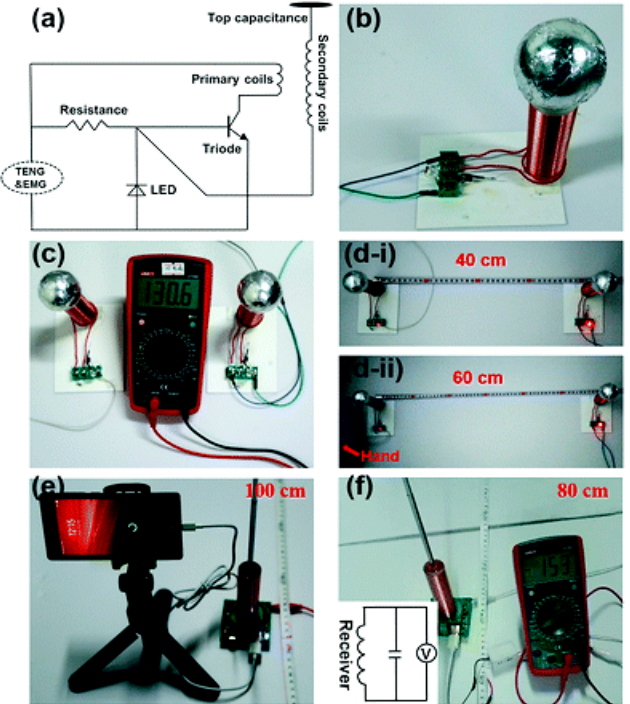
Figure 28. Wireless power transmission based on W-TENG (Wireless Triboelectric Nanogenerator). Equivalent-circuit model for the emission section ( a ), photographs of the transmitter ( b ), output current of 130.6 mA by the hybridized nanogenerator through two DC transformers with 5 V output ( c ), transmission distance of the WPT system: 40 cm ( d-i ) and 60 cm ( d-ii ) with a hand besides the